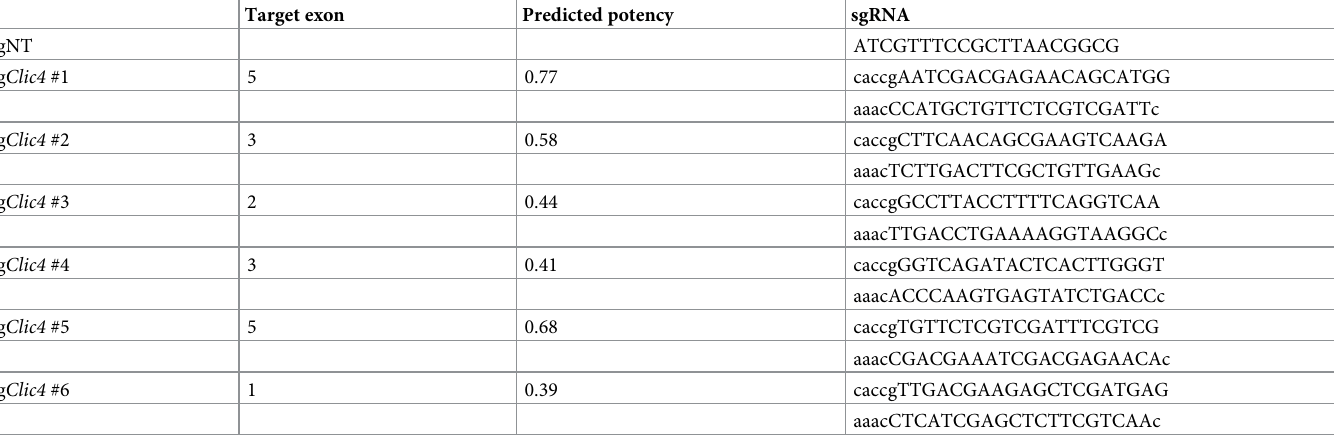
Table 1. sgRNA sequences used for CLIC4 deletion by CRISPR/Cas9.